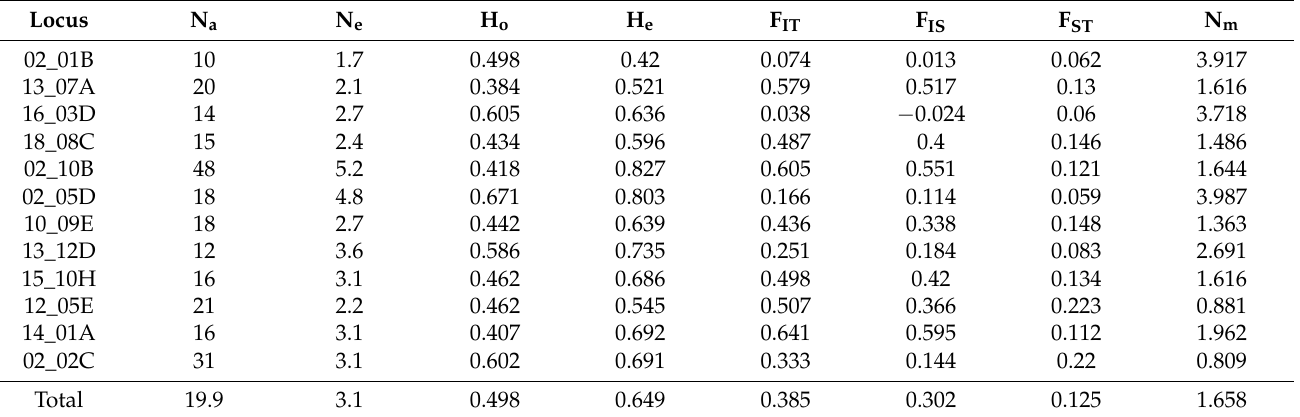
Table 3. Descriptive statistics for all SSR loci. The mean number of observed (N a ) alleles per locus, mean number of effective (N e ) alleles per locus, observed heterozygosity (H o ), expected heterozygosity (H e ), inbreeding coefficients (F IT and F IS ), fixation index (F ST ), and gene flow estimates (N m ) are reported for each SSR locus.